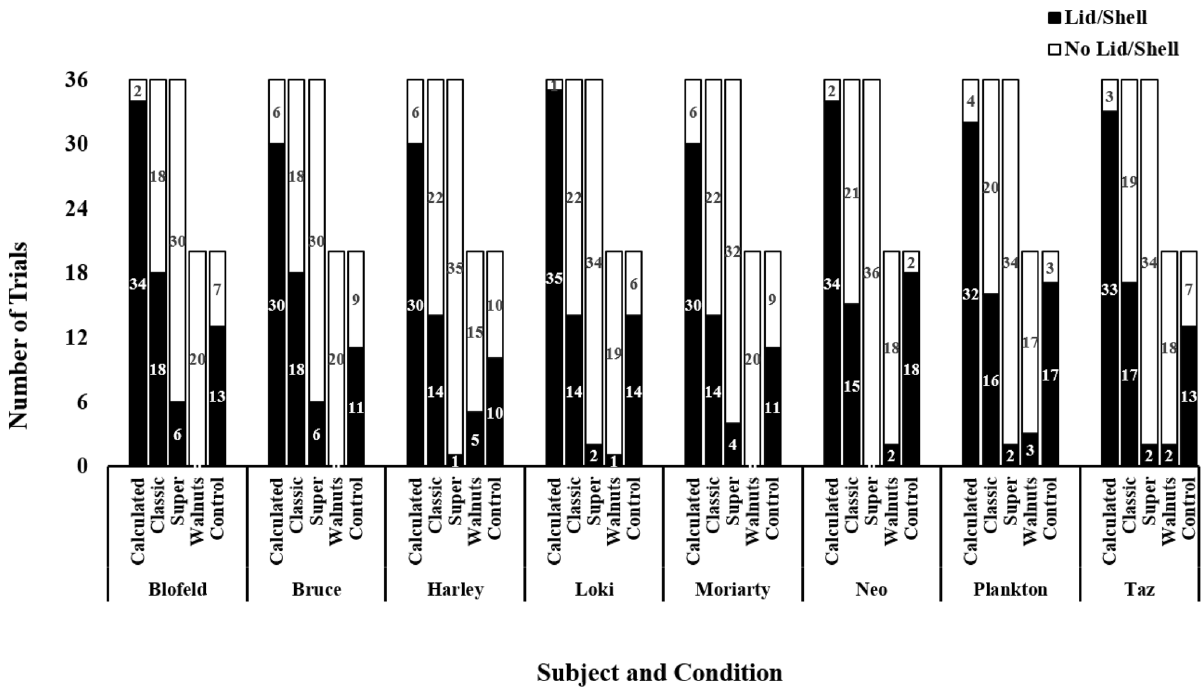
Figure 1. Contrafreeloading across kea and trial